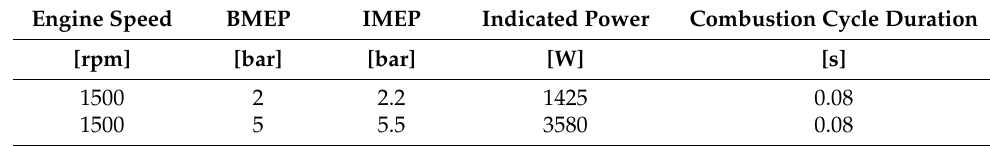
Table 2. Main parameters of the engine operating